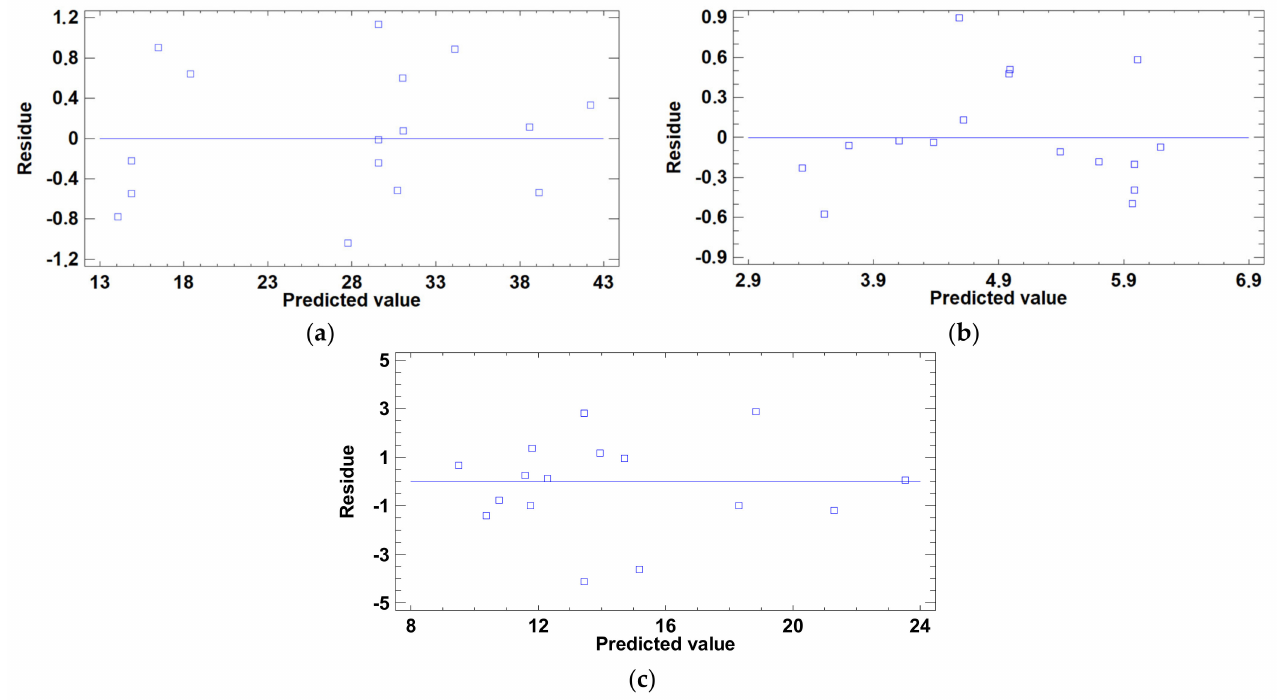
Figure 2. Residual analysis against the values obtained from the mathematical models for the responses: ( a ) biocrude yield, ( b ) nitrogen content in the biocrude and ( c ) oxygen content in the